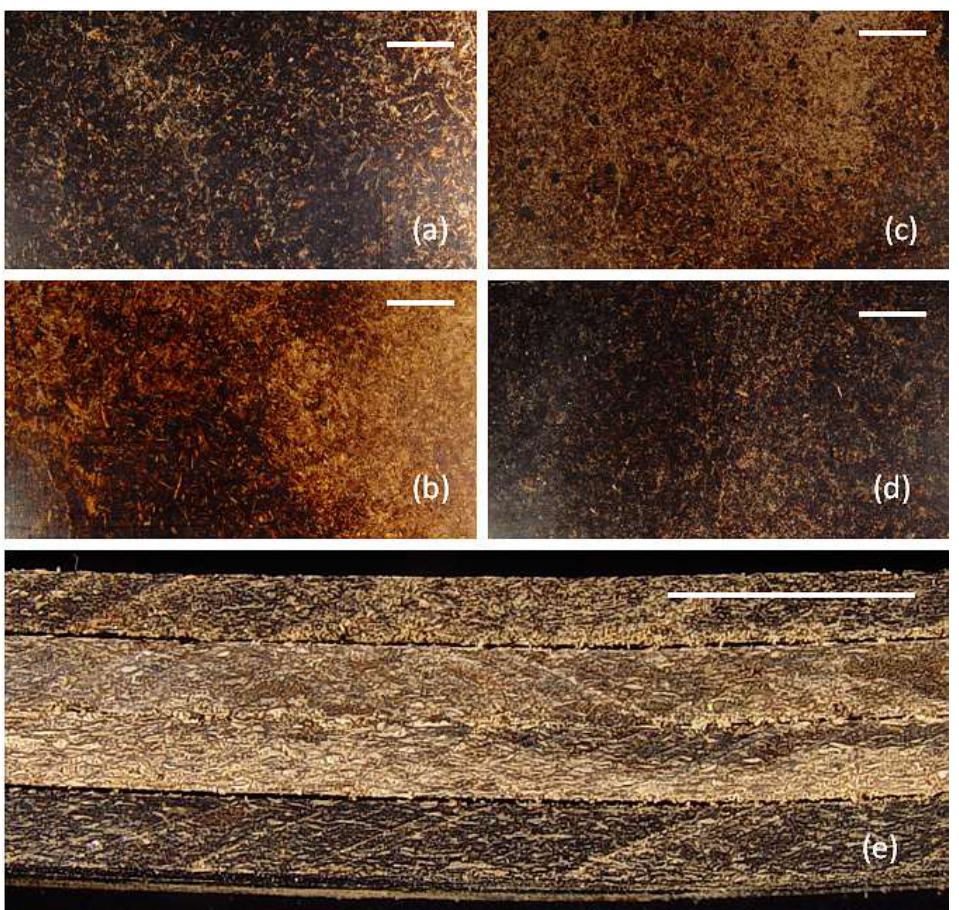
Figure 2. Optical images of surface and sawn cross sections of lesquerella composites. ( a ) LPC-PW surface; ( b ) LPC/E-PW surface; ( c ) LPC/CO 2 -PW surface; ( d ) LPC/H-PW surface; and ( e ) cross sections of biocomposites, from top to bottom: LPC-PW, LPC/E-PW, LPC/CO 2 -PW, and LPC/H-PW. Bar = 10 mm.